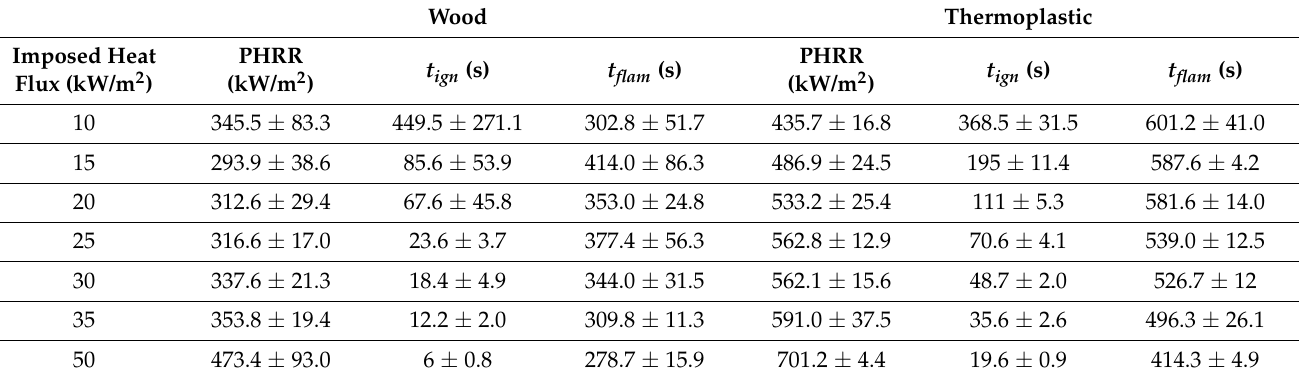
Table 3. HRR peak, t ign and t flam phase for wood and thermoplastic samples for different heat fluxes.